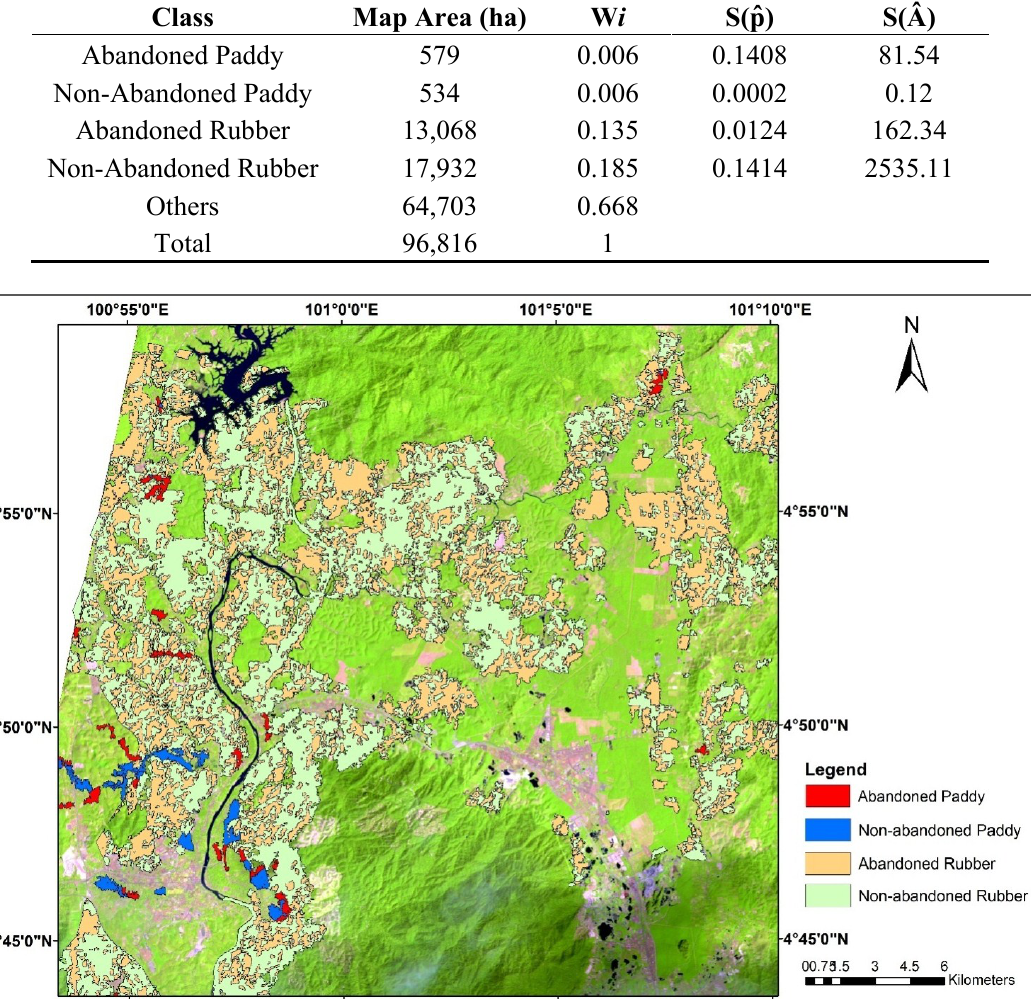
Table 4. Standard Error S(p̂ ) and Standard Error of Adjusted Area, S(Â).